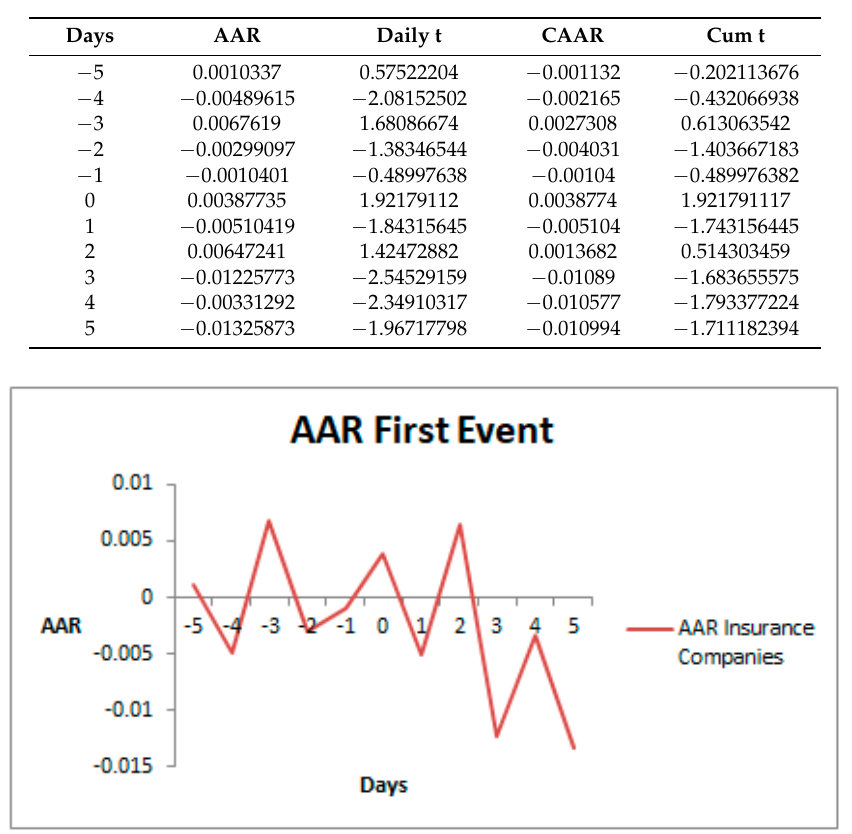
Table 6. Event study results of insurance companies for the first event. Source: Authors’ work.